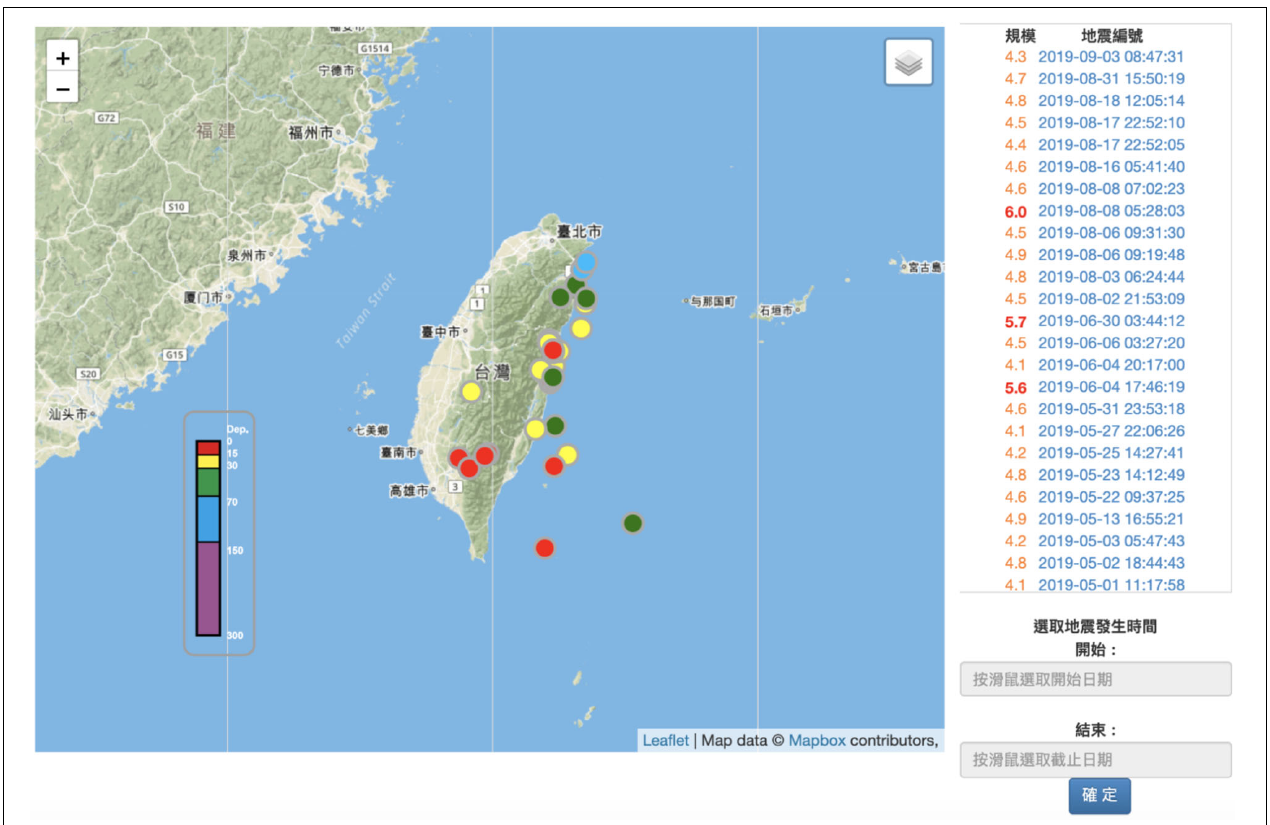
FIGURE 3 | Website of School QCN network. Circles represent the recorded earthquakes colored coded by focal depth. The list of earthquakes on the right panel shows the date and magnitude for M L ≥ 4 events, which allows the volunteers to access the waveforms in each QCN